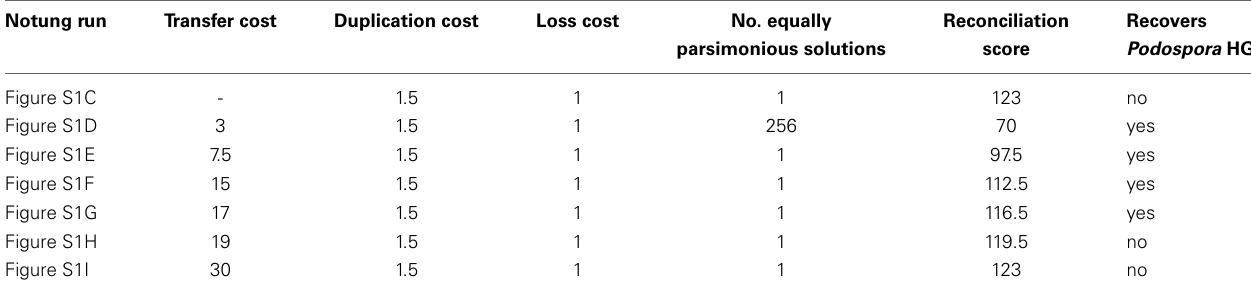
Table 2 | Example gene tree-species phylogeny reconciliation analysis using Notung v2.8 (Vernot et al., 2007; Stolzer et al., 2012). Notung run Transfer